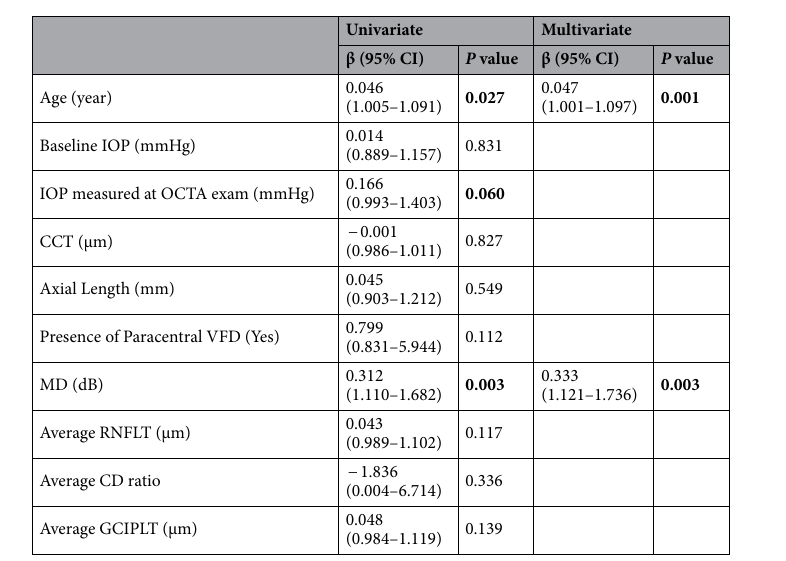
Table 6. Logistic regression analysis of factors associated with the presence of wider deep vascular defect. CI confidence interval, IOP intraocular pressure, CCT central corneal thickness, VFD visual field defect, MD mean deviation, RNFLT retinal nerve fiber layer thickness, CD cup disc, GCIPLT ganglion cell inner plexiform layer thickness. Variables with P < 0.10 were included in the multivariate analysis. Factors with statistical significance are shown in